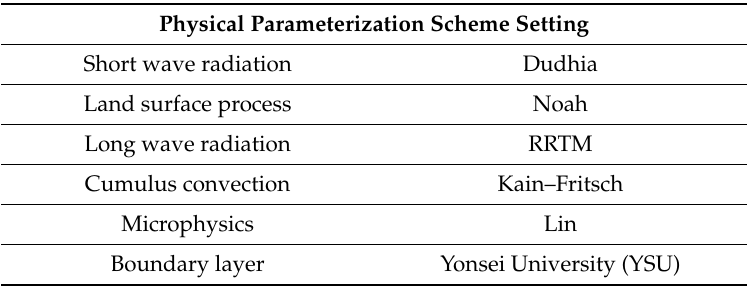
Table 1. Main physical parameterization schemes of the